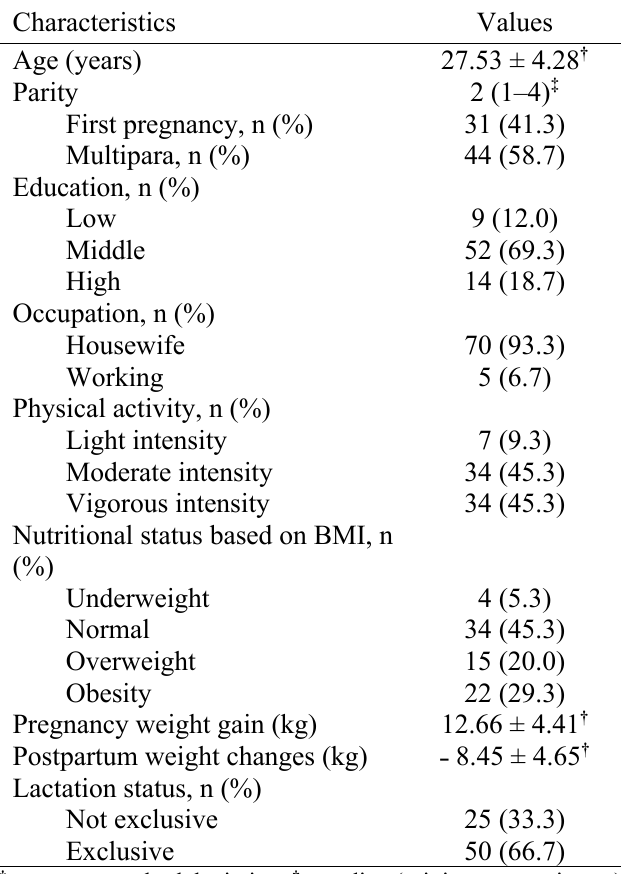
Table 1. Baseline characteristic of the subjects